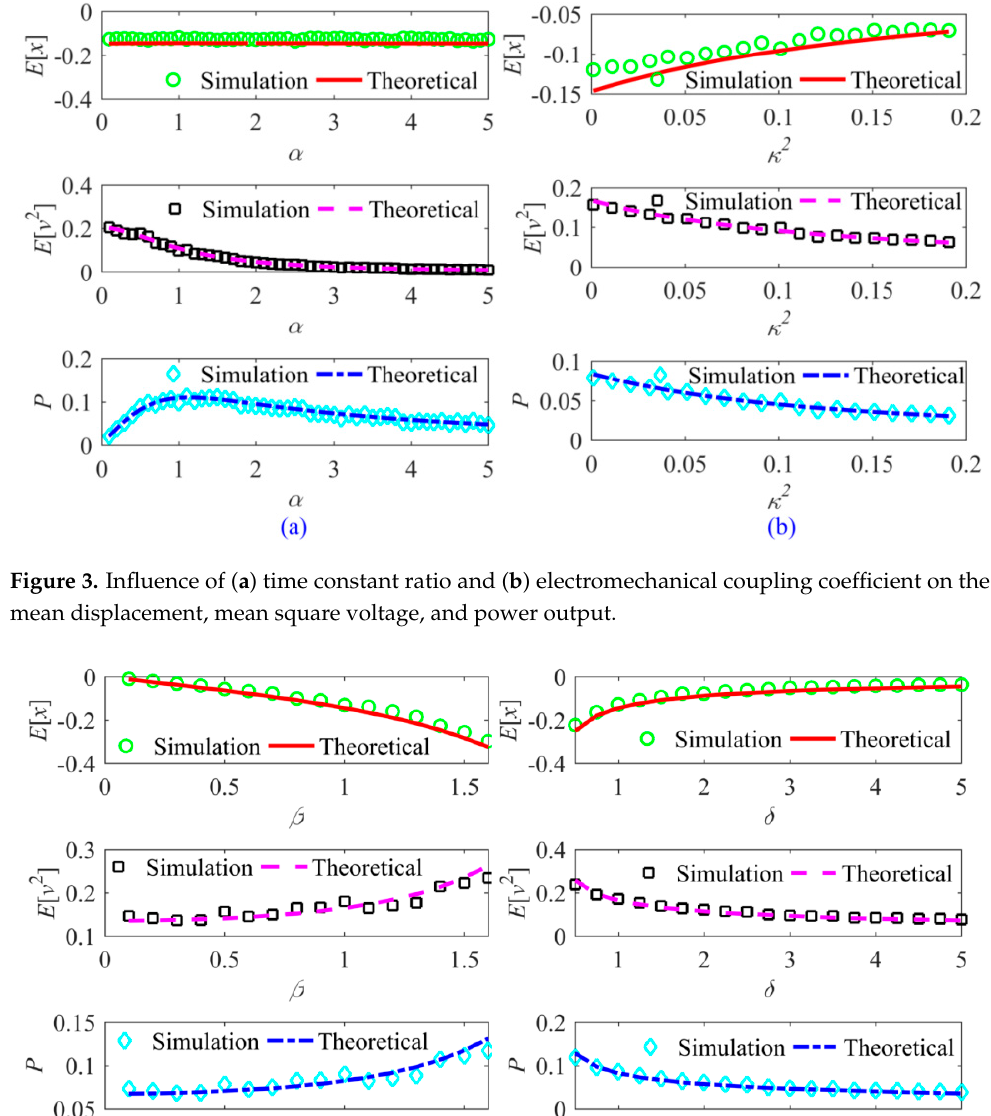
Figure 5. Influence of correlation time on the mean displacement, mean square voltage, and power output. In order to investigate the response of asymmetric MEH subjected to color noise more specifically, Figure 6 illustrates the typical nonlinear restoring forces and potential energy functions of the asymmetric MEHs with different values of the quadratic coefficient: 0, 1.0, 1.5, and 1.9. The results showed that the increase in the quadratic coefficient results causes the potential energy functions to have smaller values on the left side of the equi- librium position. Under color noise with an intensity of 0.05, the time history of voltage responses of four asymmetric MEHs with different values of the quadratic coefficient are